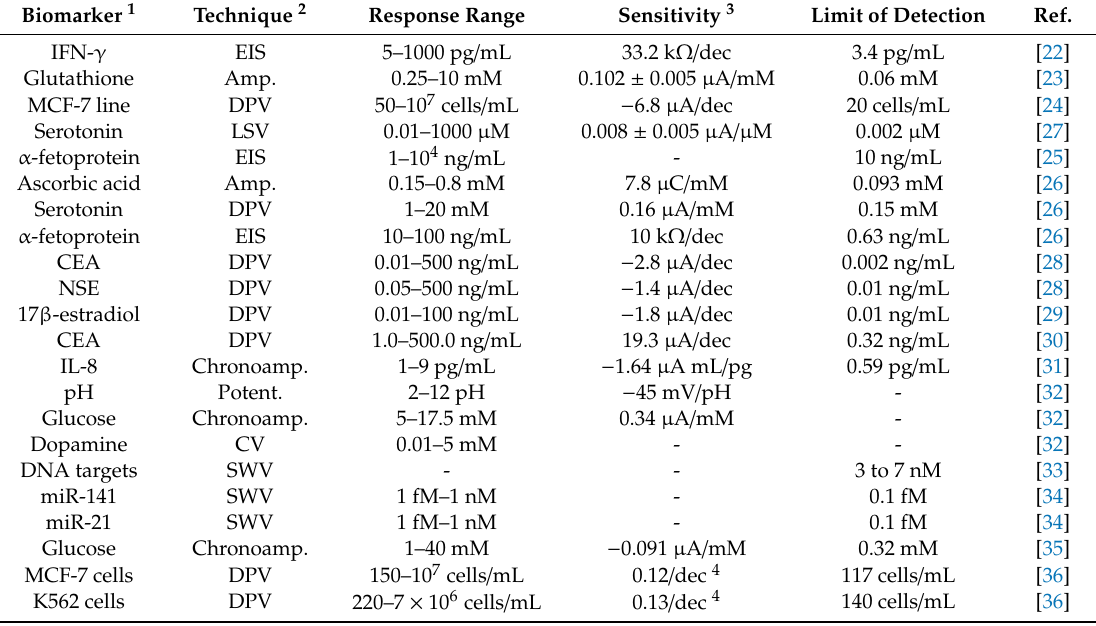
Table 1. Analytical features of the described PADs with integrated electrochemical